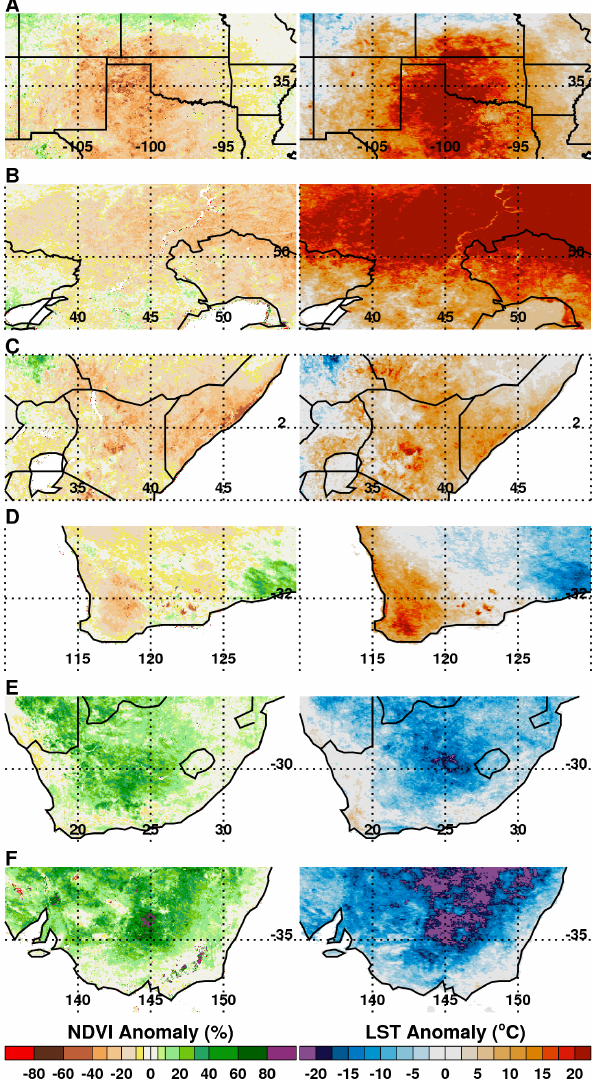
Figure 1. MODIS normalized difference vegetation index (NDVI) and land surface temperature (LST) anomalies for selected growing seasons and regions during 2010–2012. The NDVI quantifies photosynthetic potential of vegetation using satellite- measured reflected radiances in the infrared and red wavelengths [25,26]. We calculated monthly and seasonal NDVI and LST anomalies by expressing differences between current and mean 2000–2011 NDVI values. NDVI anomalies are expressed as percentage departures, and LST anomalies are absolute departures from long-term means. (A) Texas, US June, July, August (JJA) 2011, (B) SW Russia (Volga District) JJA 2010, (C) East Africa (Somalia/Kenya) DJF 2010/11, (D) SW Australia (Western Australia) SON 2010, (E) South Africa (Free State/North West) DJF 2010/11, (F) SE Australia (New South Wales) SON 2010.